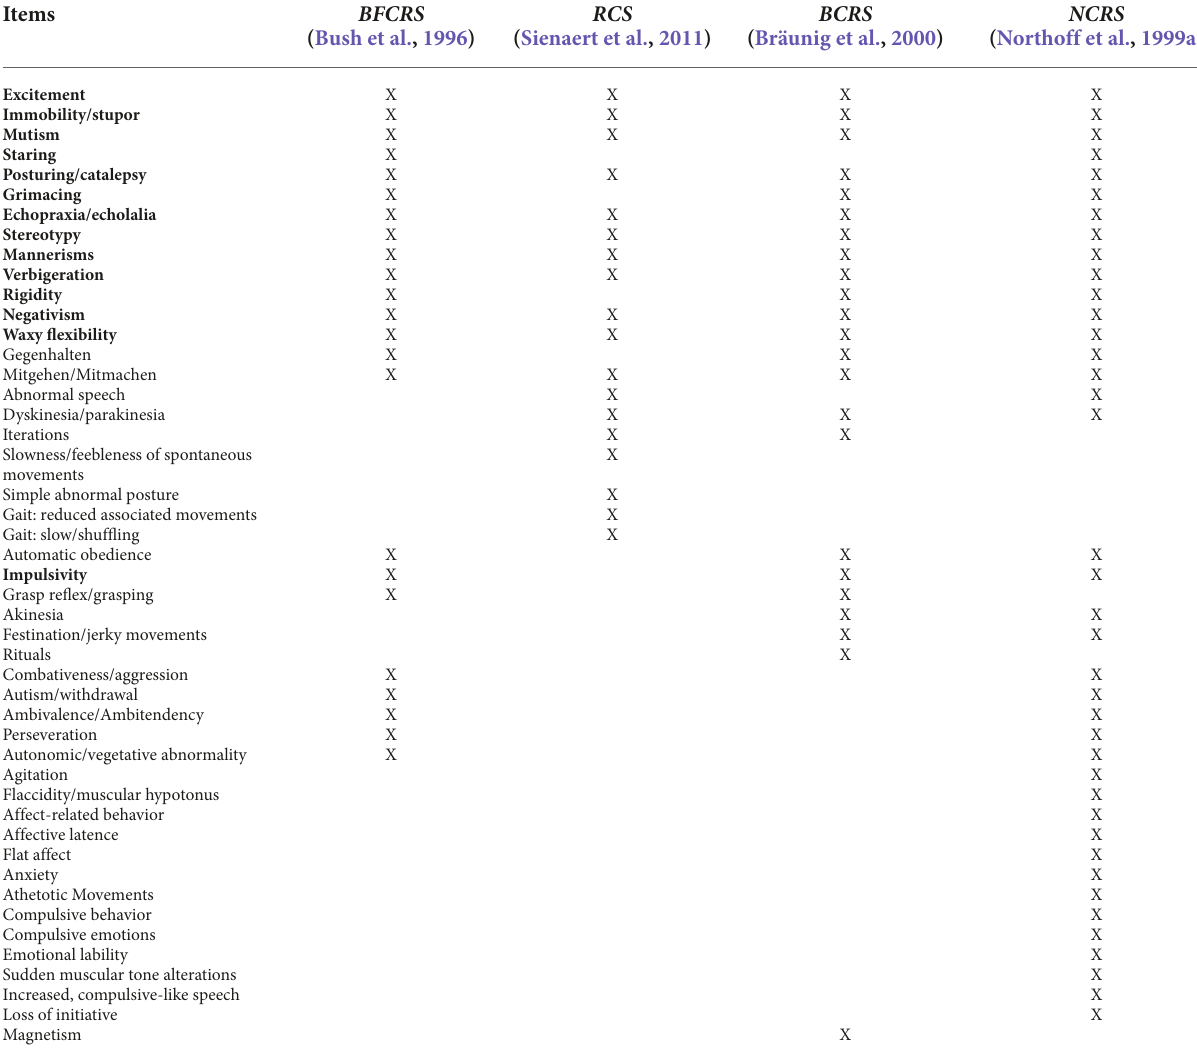
TABLE 1 Diagnostic scales comparison: Bush–Francis Catatonia Rating Scale (BFCRS), Rogers Catatonia Scale (RCS), Braunig Catatonia Rating Scale (BCRS), Northoff Catatonia Rating Scale (NCRS). Items